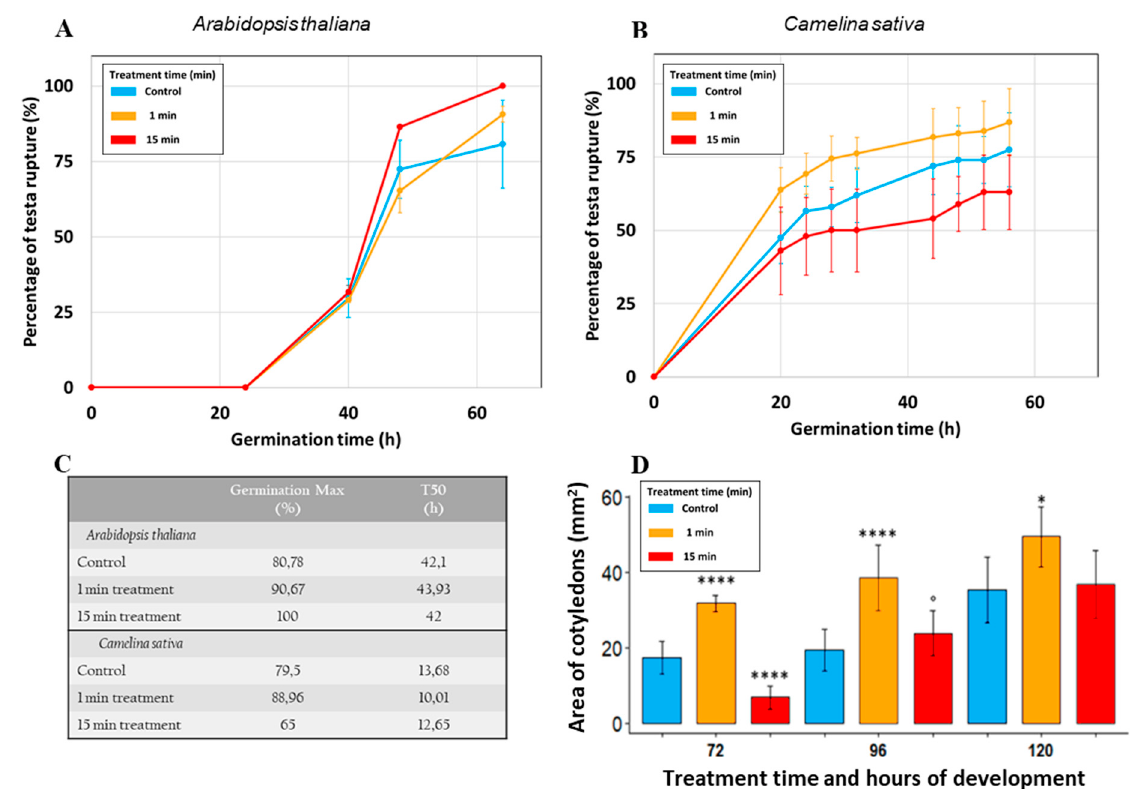
Figure 1. Germination parameters of A. thaliana and C. sativa seeds after two exposure times (1 and 15 min) to DBD air plasma with the comparisons to control seeds. Graph A shows the testa rupture of A. thaliana seeds and graph B shows the testa rupture of C. sativa . ( A , B ): The testa rupture is evaluated as a function of the development time for different treatment times (0, 1 and 15 min). The blue curves represent the control seeds, the orange curve the 1 min plasma-treated seeds and the red the 15 min-treated seeds ( C ): Maximum of germination (Gmax) for each seed and treatment time, and the T50 which is the time (in hours) needed to reach half of the Gmax. ( D ): Area of C. sativa cotyledons. The establishment of the C. sativa cotyledons is noted with pictures of germinated seeds and image analysis which allows the measurement of the area of the cotyledons. Those measurements were done on 10 Petri dishes at least three different times. The significance deviations were determined using the Kruskal–Wallis tests between the control and plasma-treated seeds: °: p -value < 0.1, *: p -value < 0.05, ****: p -value < 0.00005.